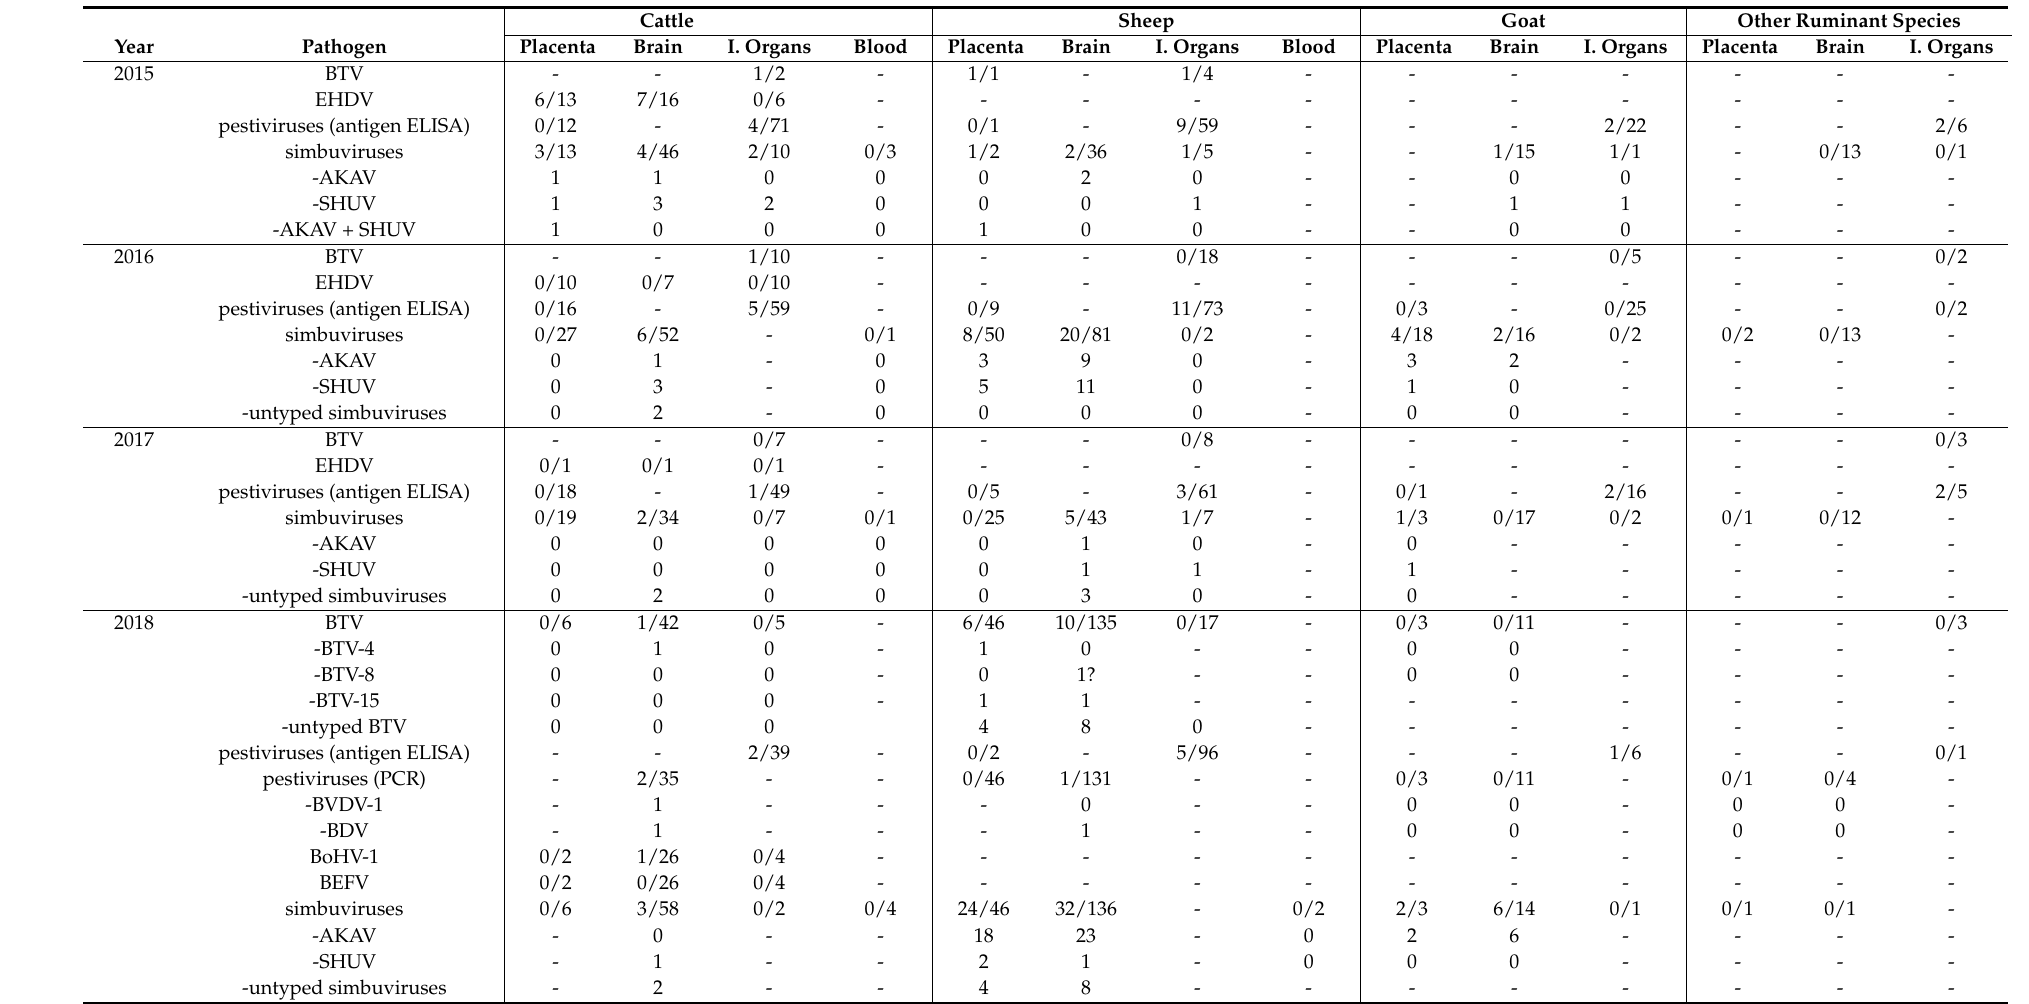
Table 1. Data on detection and identification of viral genome or antigen in tissue and blood samples collected from aborted fetuses or malformed newborn animals of domestic and non-domestic ruminants. From cattle and sheep, placenta, brain, internal organs (i.organs) and blood were investigated, while for goats and other ruminant species placenta, brain and internal organs were included. The number of positive results/number of investigated samples per animal species and clinical specimen is